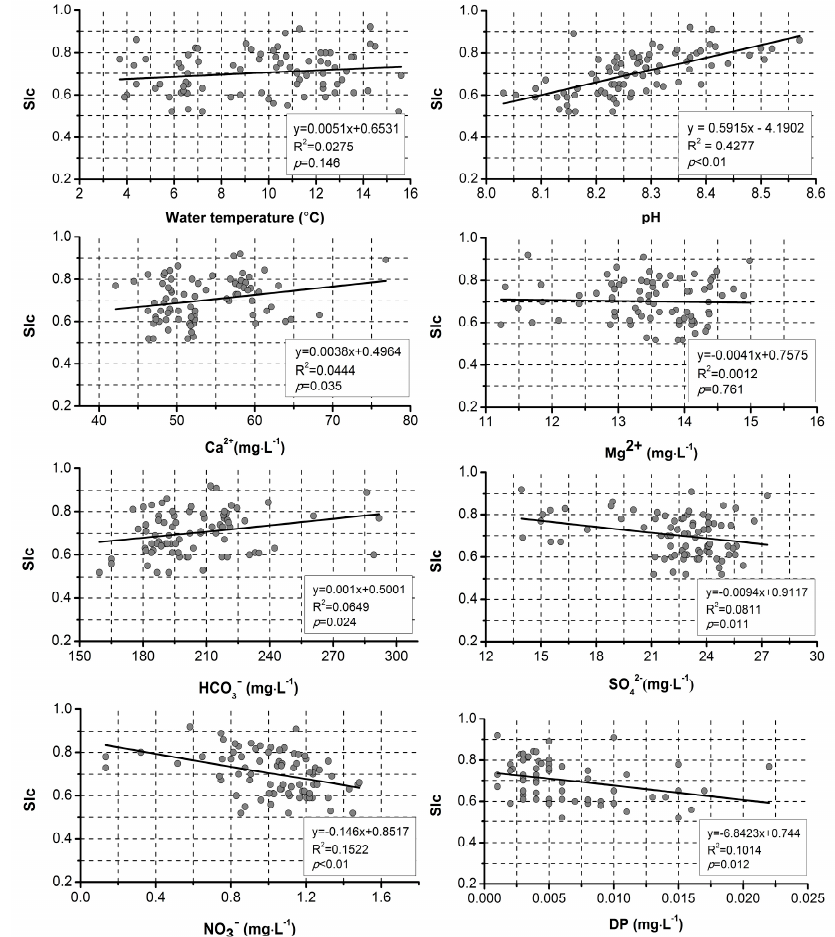
Figure 6. Linear fit between SIc and hydrochemical variables for the studied sites.